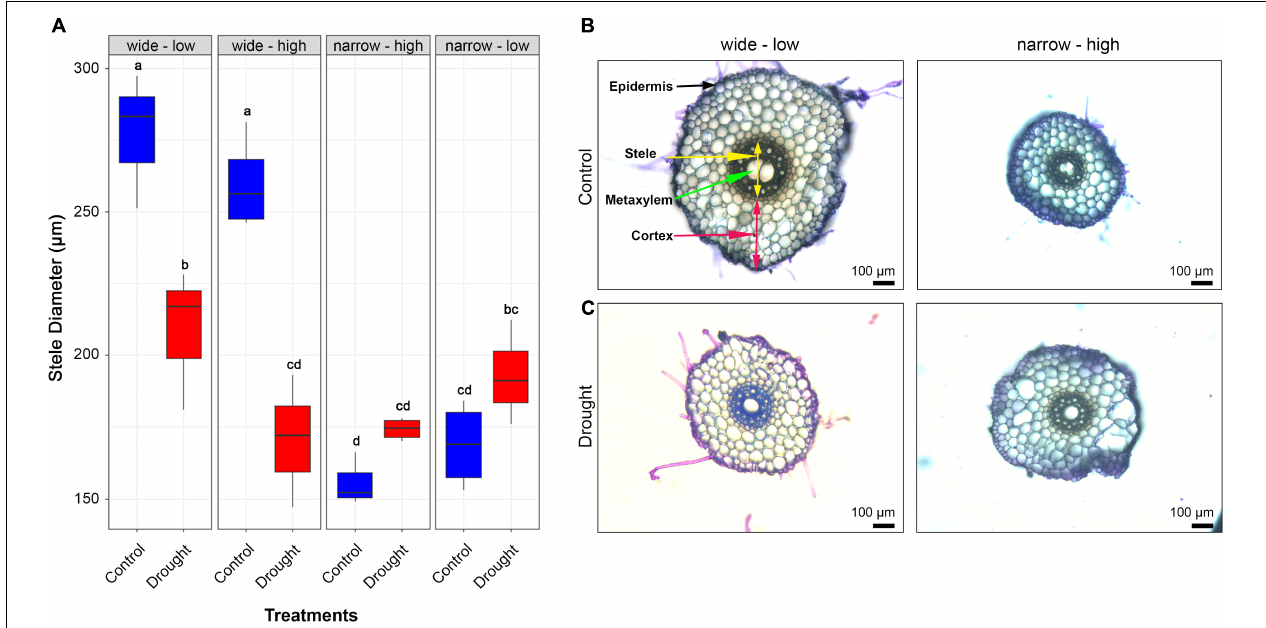
FIGURE 8 | Anatomical features of roots sampled from durum wheat genotypes representative of distinct root system ideotypes. (A) Stele diameter of the four root ideotypes of samples collected 10 cm from root apex, under well-watered (control; boxplot colored in blue) and drought conditions (boxplot colored in red). Mean stele diameter with different letters above the boxplot are significantly different. Radial root cross sections on seminal root at 10 cm from root apex displaying anatomical variation in the root ideotype wide root angle with low biomass (B) and narrow root angle with high root biomass (C) under well-watered and drought conditions, scale bars in the cross sections = 100 µ